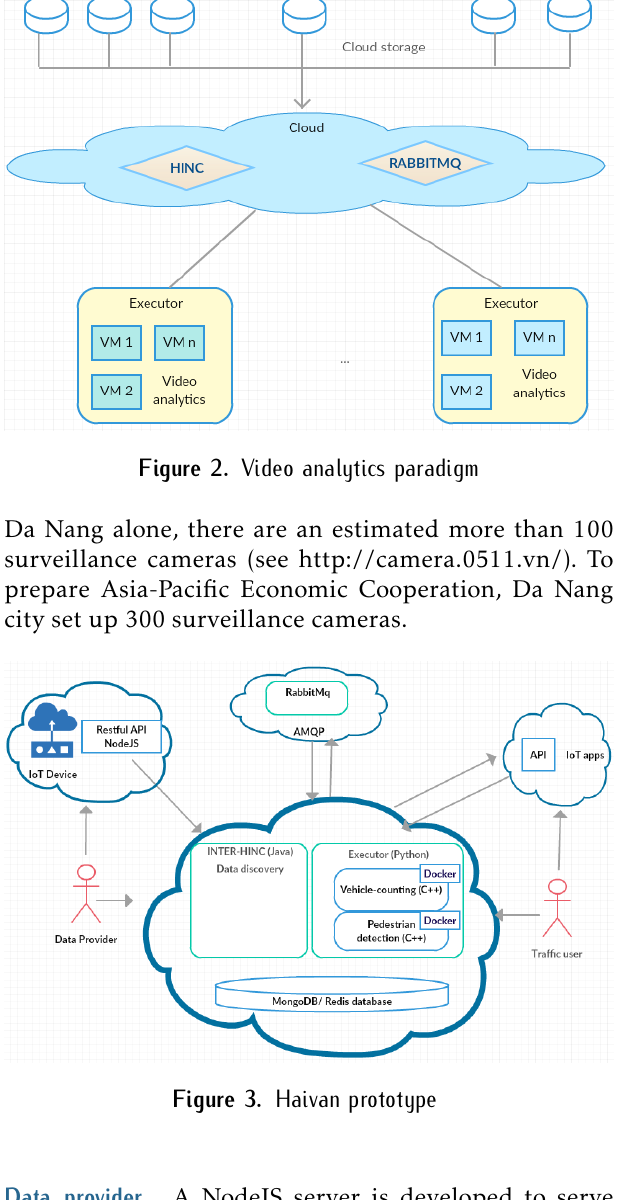
Figure 4. Provider Return Camera List